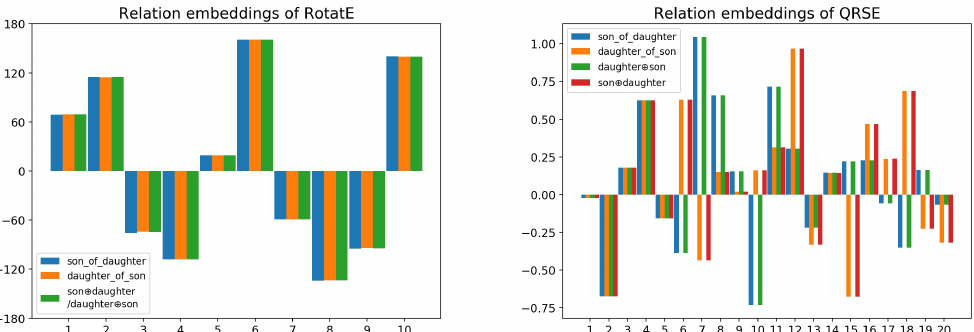
Figure 5. The relation embeddings of RotatE and QRSE on training step 16,000. A relation embedding of RotatE has 10 complex numbers with modulus 1, which are determined by their 10